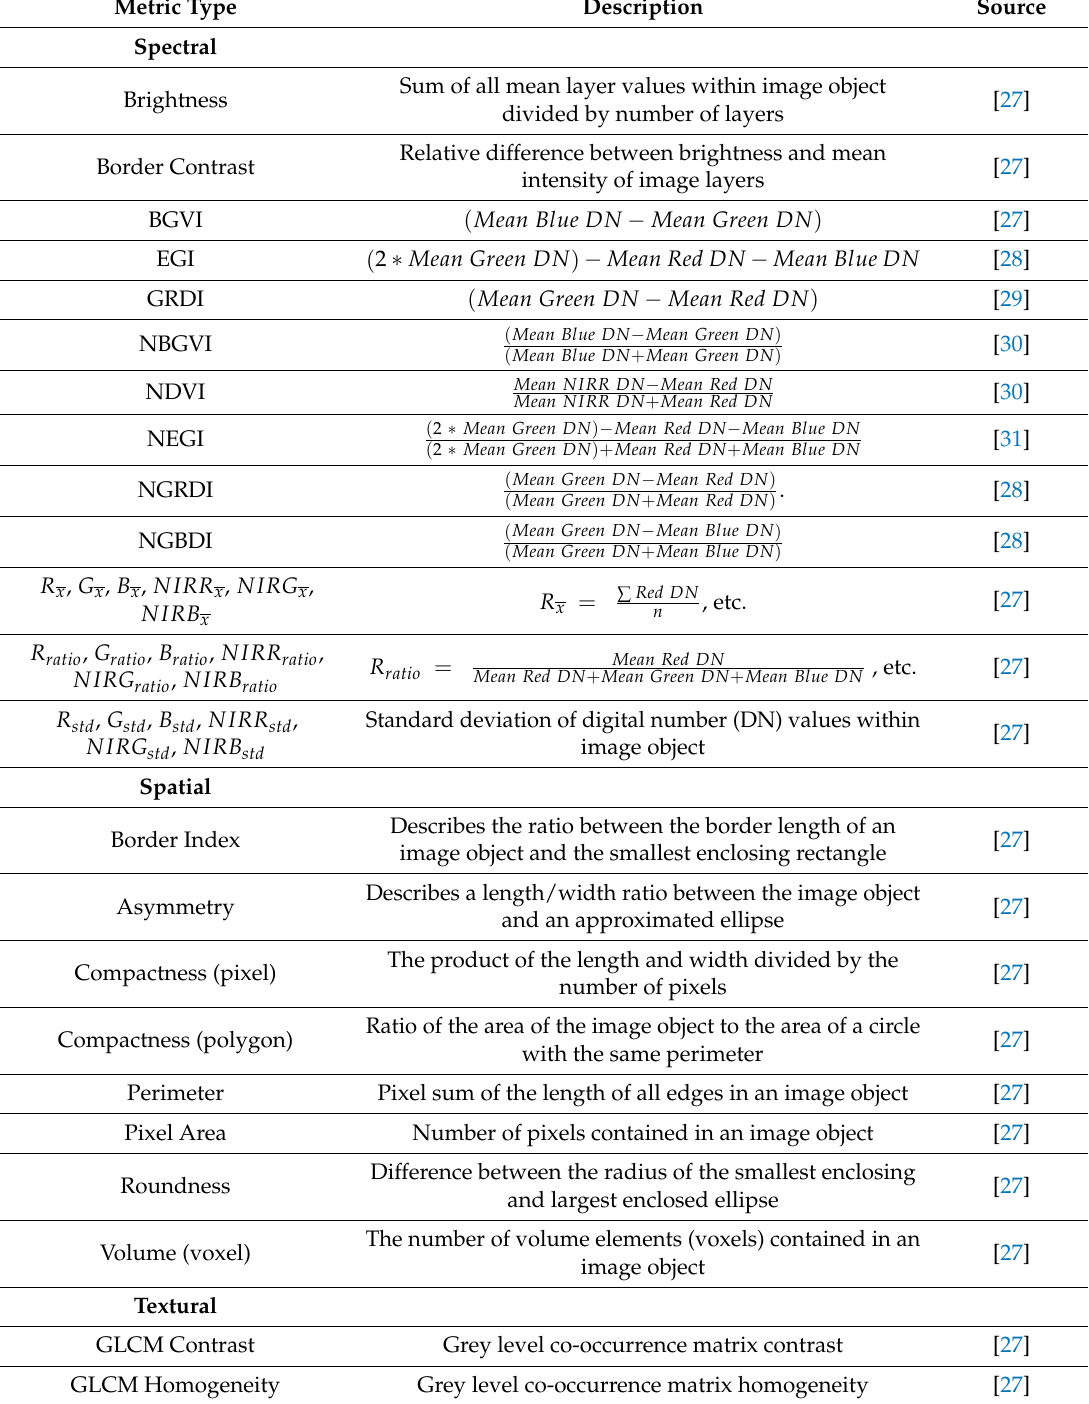
Table 2. Spectral, spatial, and textural attributes of image objects used for classification and regression tree (CART)